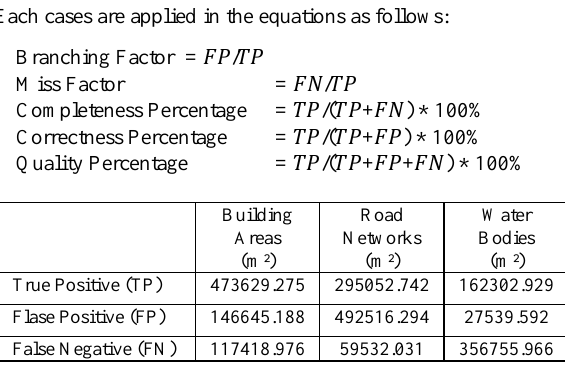
Table 2. Total count of each object layer in the study area